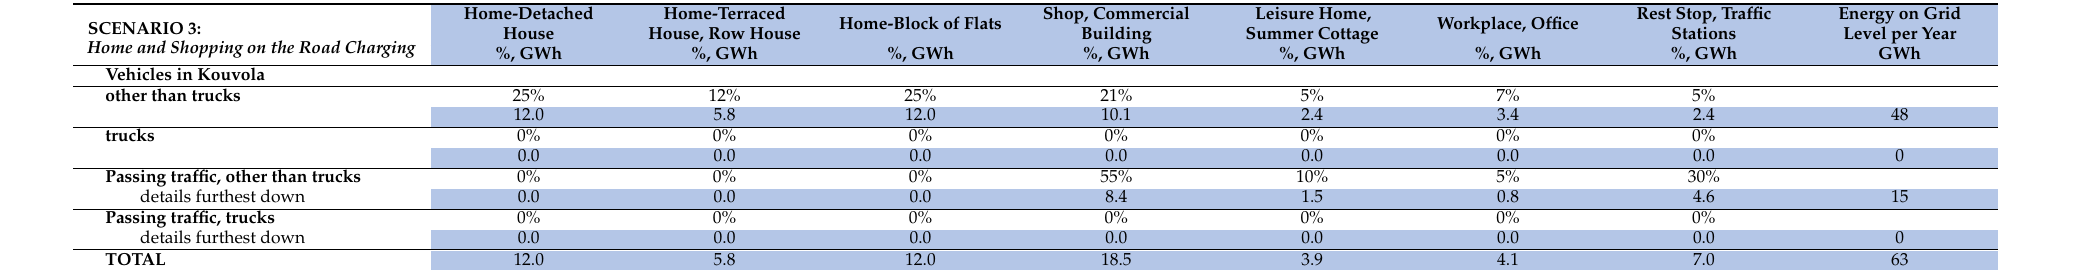
Table A8. Kouvola-based and passing traffic: subdivision of additional energy into user groups. Percentages indicate the share of consumption